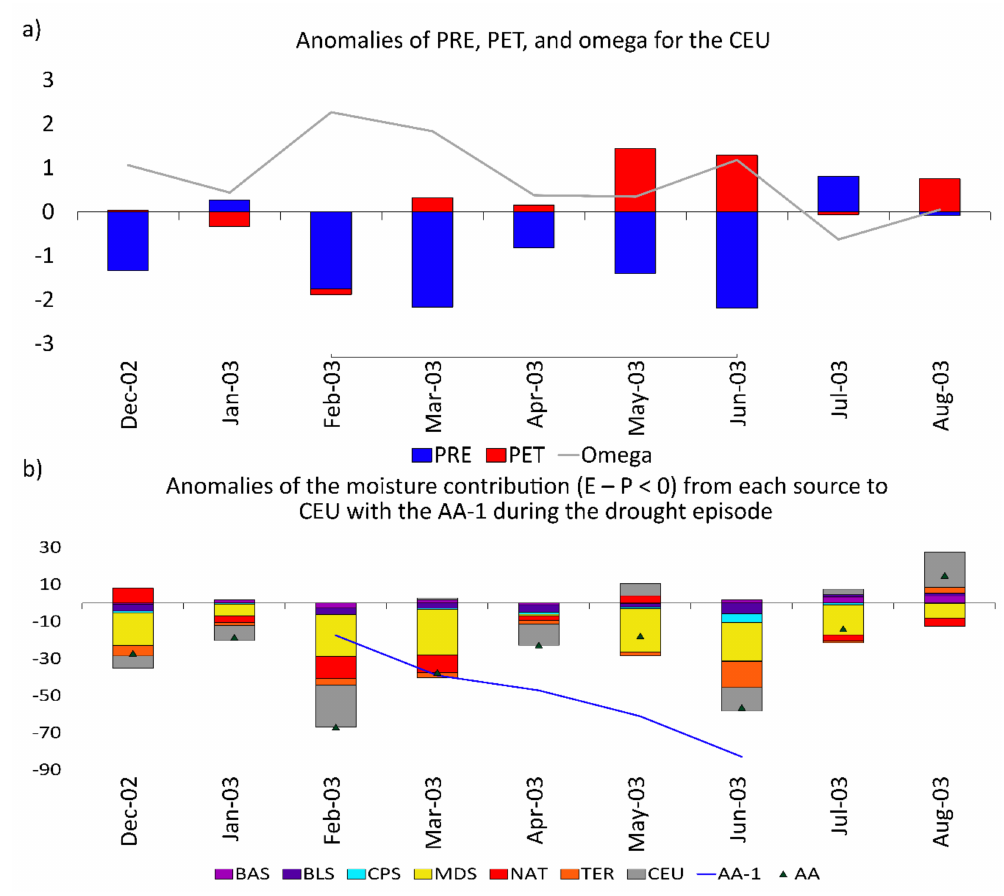
Figure 7. ( a ) Monthly anomalies of the precipitation (PRE, /10 mm/month), potential evapotranspiration (PET, /10 mm/month) (data from Climatic Research Unit (CRU) Time-Series (TS) 3.24.01), and average pressure velocity at 500 hPa (data from ERA-Interim) over the Central European region (CEU); and ( b ) Anomalies in the moisture supply (E − P < 0) for each source over CEU, obtained via the forward FLEXible PARTicle (FLEXPART) experiment (mm/day) with the accumulated anomaly of the supply from all of the sources (AA, mm/day) and the accumulated precipitation anomalies (AA-1, mm/month) (data from CRU 3.24.01) for the episode from February 2003 to June 2003.